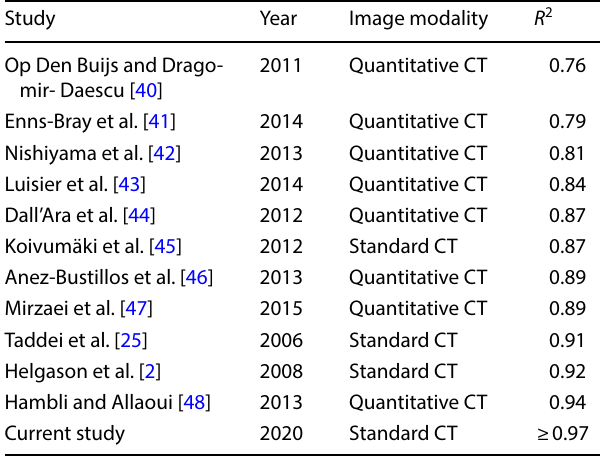
Table 6 Result comparisons for stress studies using the finite ele- ments method